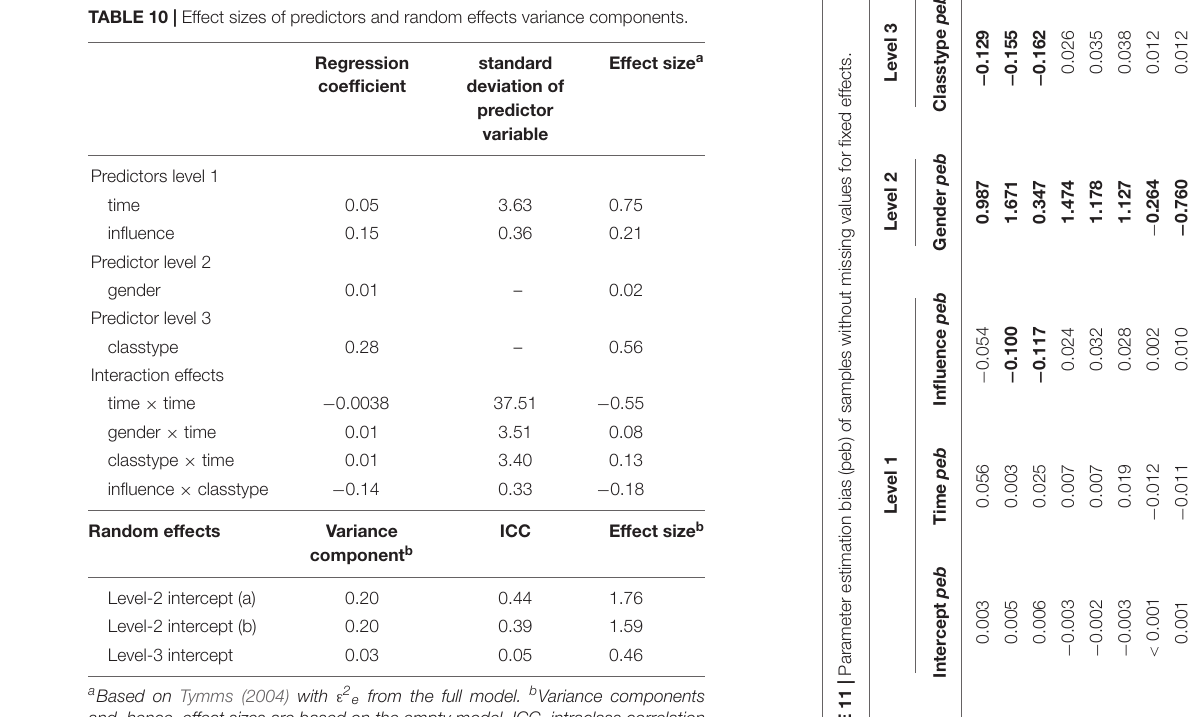
TABLE 10 | Effect sizes of predictors and random effects variance